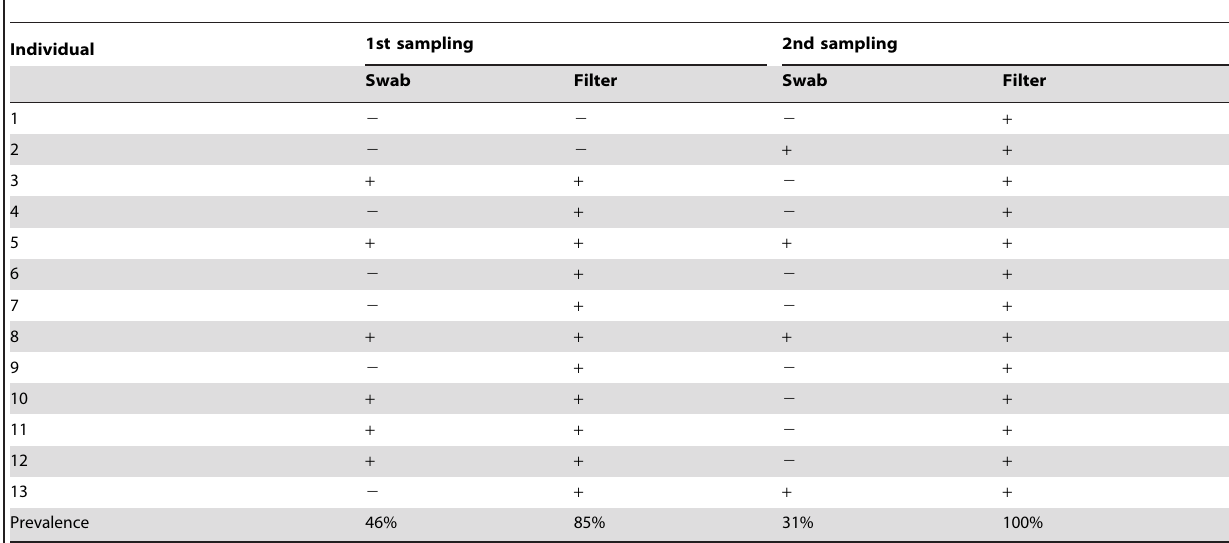
Table 1. Infection status of subjects and prevalence estimates based on qPCR of DNA extracted from swabs and filtered zoospores taken at 24 h and 16 days.